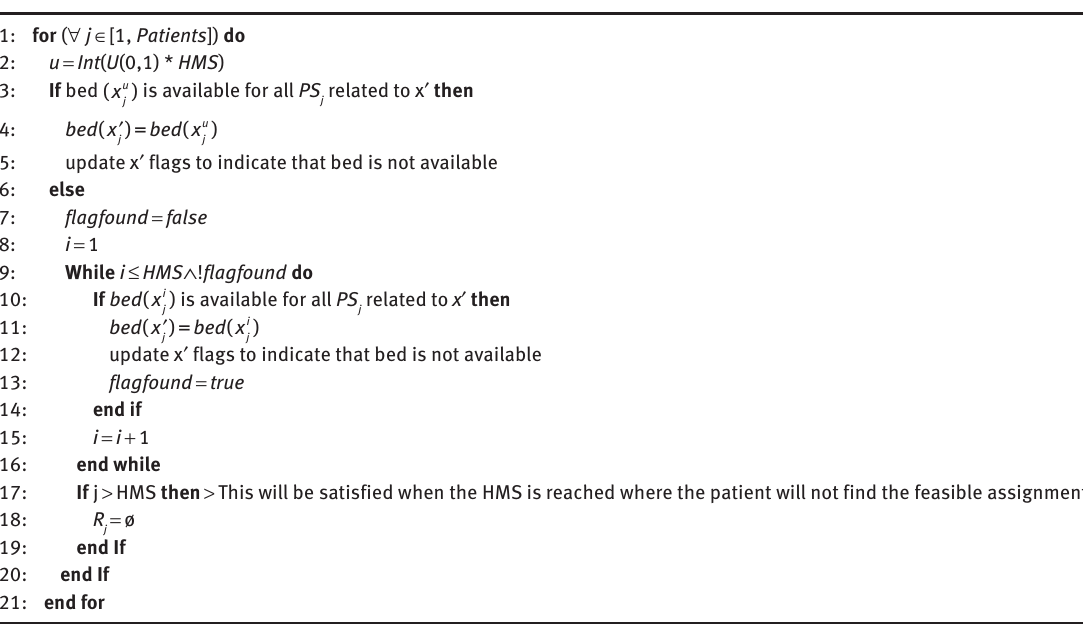
Algorithm 2: Filling R